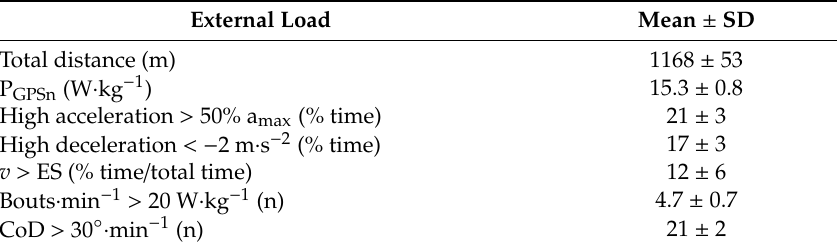
Table 6. Bioenergetic demands of the soccer-specific